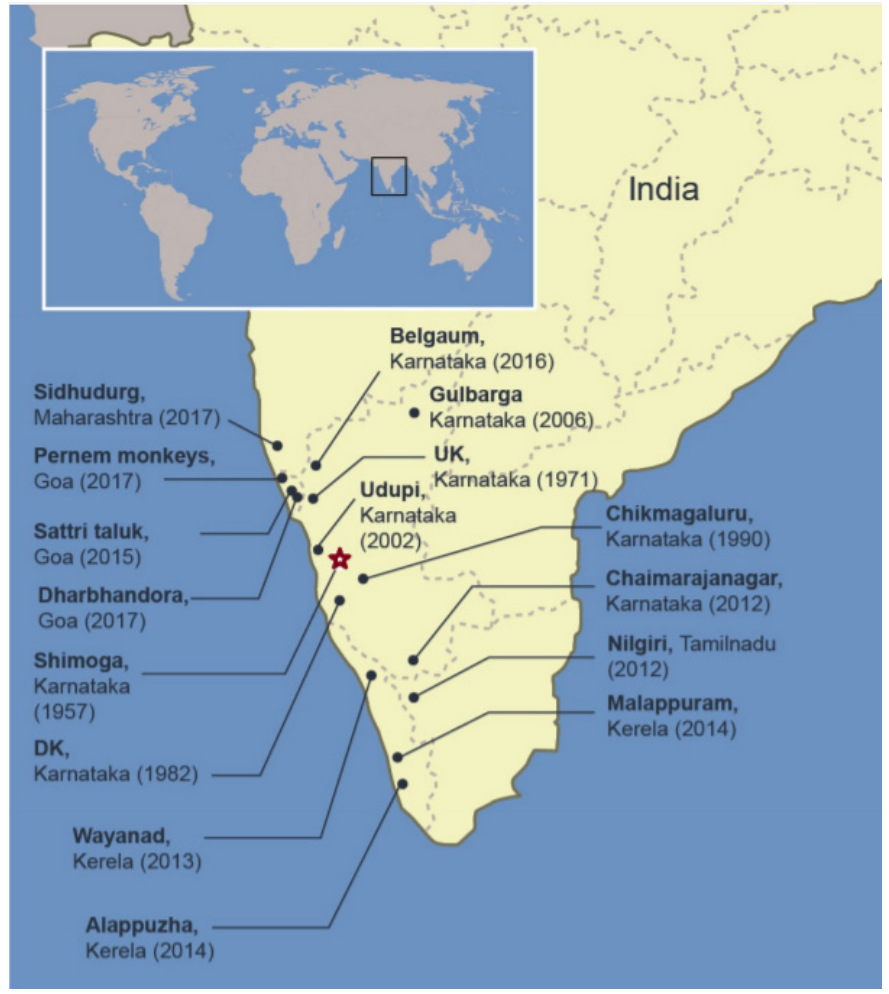
Figure 2. KFD distribution in India. Areas in the south western part of India where KFD in humans and monkeys has been reported are indicated. Place, state, and year in which the first case was reported are provided. Star represents the place of the first isolation from a monkey. UK Uttar Kannada, DK Dakshina